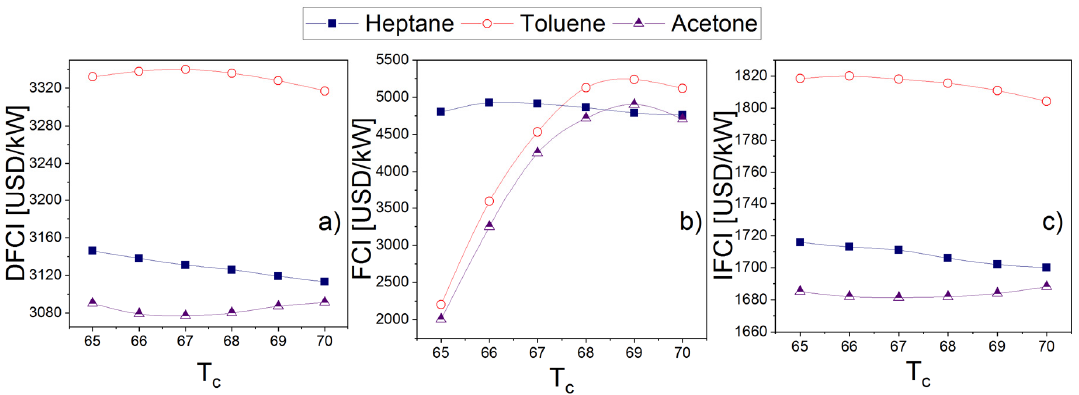
Figure 7. E ff ect of condensing temperature on investment costs for a RORC system varying ( a ) DFCI, ( b ) FCI, and ( c ) IFCI.